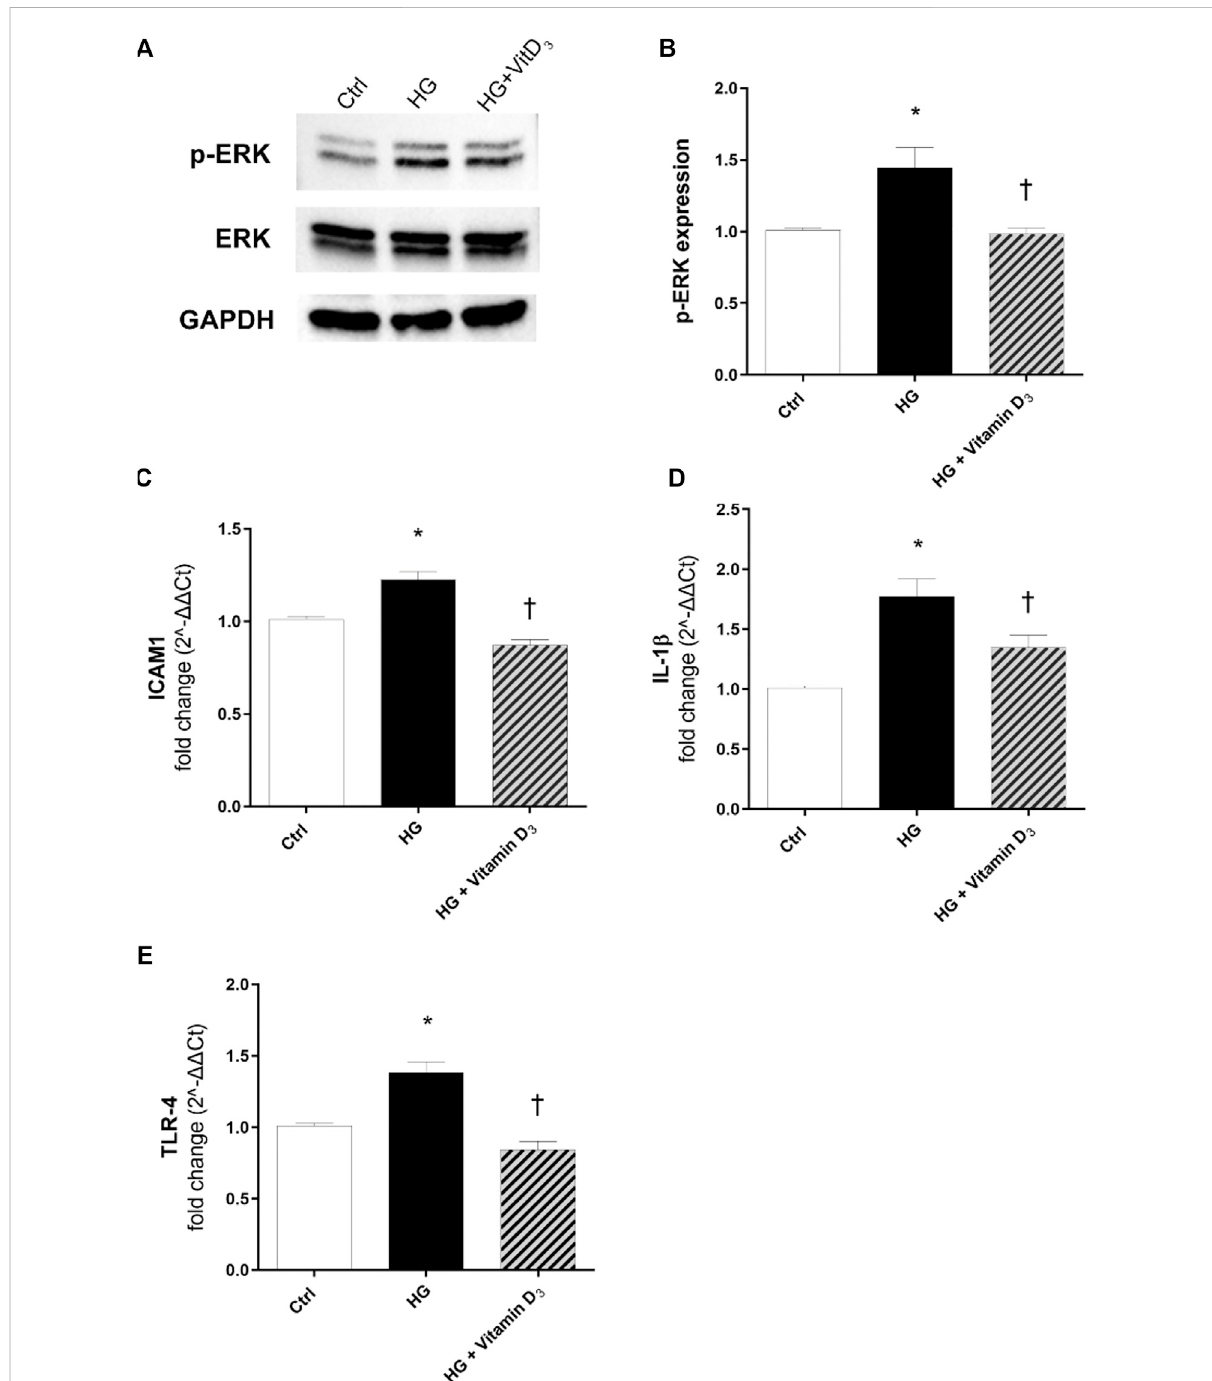
FIGURE 5 Vitamin D 3 counteracts in fl ammation and angiogenesis in HREC after HG-induced damage. Vitamin D 3 effect on the in fl ammatory pathway activatedbyhighglucose(HG)inHRECs. (A) ImmunoblotanalysisofERK1/2phosphorylationinlysatesfromHRECs,pre-treatedfor24 hwithvitamin D 3 (1 µM)andsubsequentlyco-treatedwithHG(40 mM)forother24 h. (B) Bargraphsshowthedensitometryanalysisofeachband,carriedoutwith the Image J program, p-ERK densitometry has been normalized to total ERK values. The effect of HG and vitamin D 3 at mRNA levels was evaluatedafter72 hofHGchallenge.ThetreatmentwithvitaminD 3 reducedICAM-1 (C) ,IL-1 β (D) ,TLR4 (E) mRNAexpression.ThemRNAlevelswere evaluated by qPCR. Each bar represents the means ± SD ( n = 4; each run in triplicate). * p < 0.05 vs. control; † p < 0.05 vs.